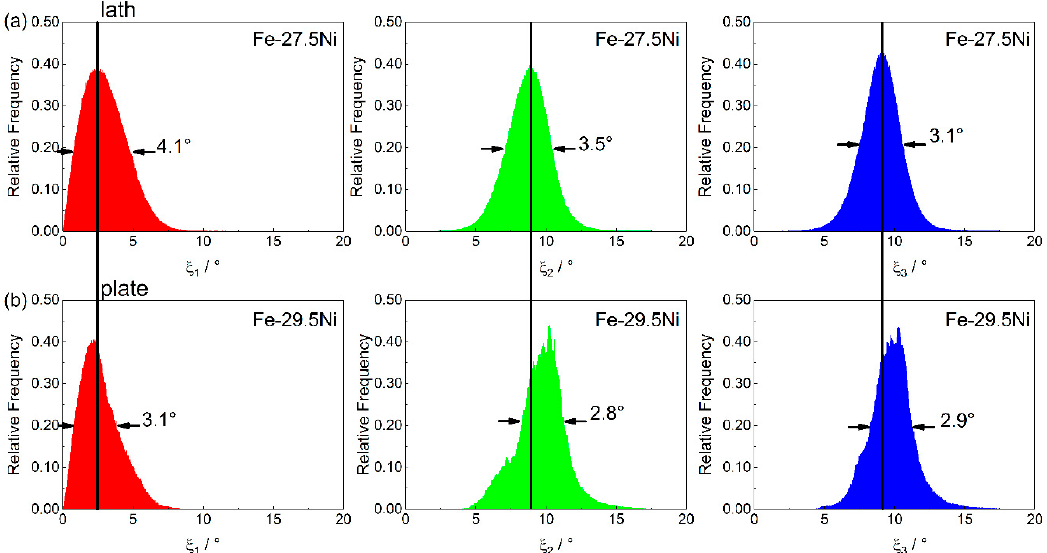
Figure 8. Histograms showing the relative frequency distributions of the characteristic angles ξ 1 (left column), ξ 2 (middle column), and ξ 3 (right column) obtained from the OI-EBSD data presented in Figure 7. ( a ) Lath martensite (Fe-27.5Ni). ( b ) Plate martensite (Fe-29.5Ni). For the angles ξ 2 and ξ 3 one finds that FWHM LM > FWHM PM . When taking the angular